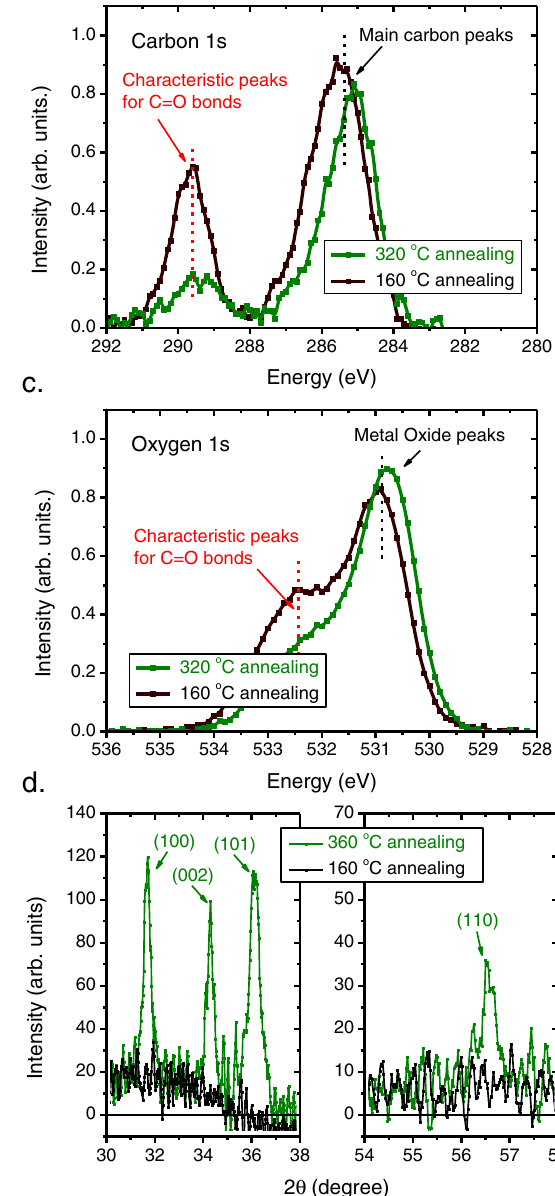
Fig. 2 | Structural and compositional properties of the ZnO fi lms annealed at different temperatures. a AFM images of the sol-gel-grown ZnO fi lm annealed at different temperatures. b XPS carbon 1s spectra and c XPS oxygen 1s spectra for